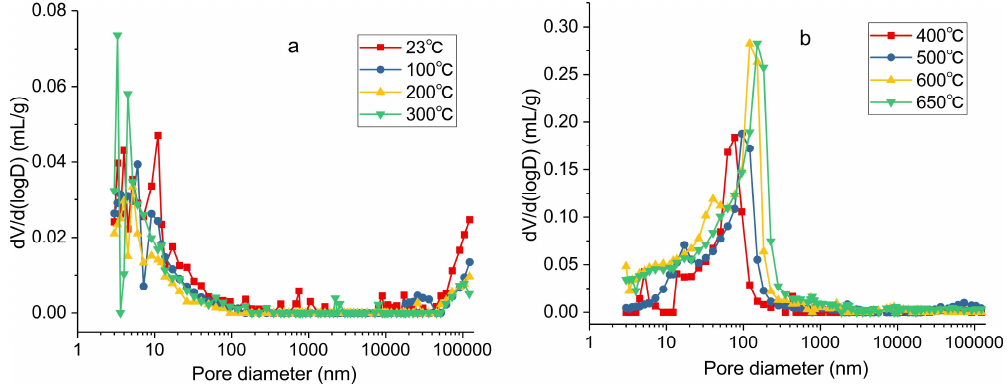
Figure 7. PSD curves at different temperatures of MIP. ( a ) 23–300 °C; ( b ) 400–650 °C. Table 3. Main pore structure parameters of MIP.